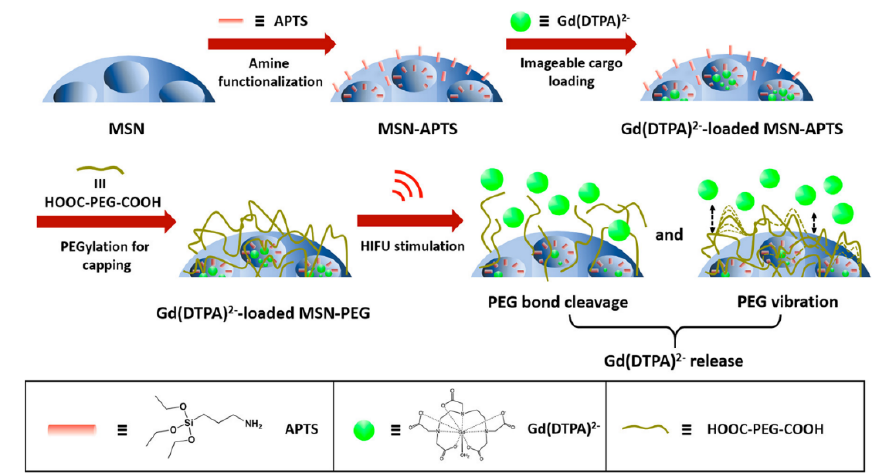
Figure 6. A schematic representation of high-intensity focused ultrasound (HIFU)-responsive magnetic resonance imaging (MRI)-active MSNs. In this work, the particles were initially amine (green) and the pore channels capped with poly(ethylene glycol) (PEG) (brown). Finally, the e ff ect of HIFU stimulation on the release of Gd(DTPA) 2 − can be observed. Reprinted with permission from reference [94]. Copyright (2019) American Chemical Society.